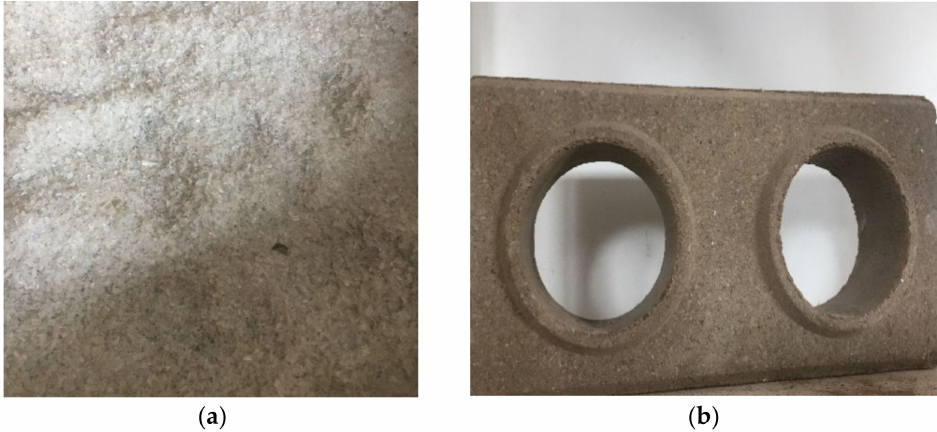
Figure 1. Materials used: ( a ) PET waste; ( b ) soil-cement